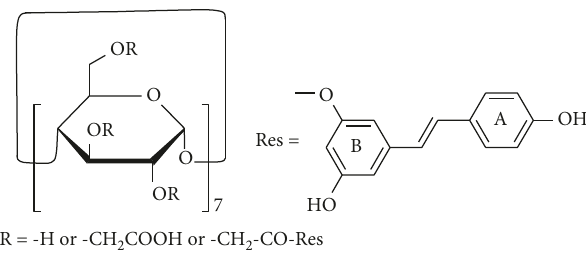
Figure 1: The structure of resveratrol. Figure